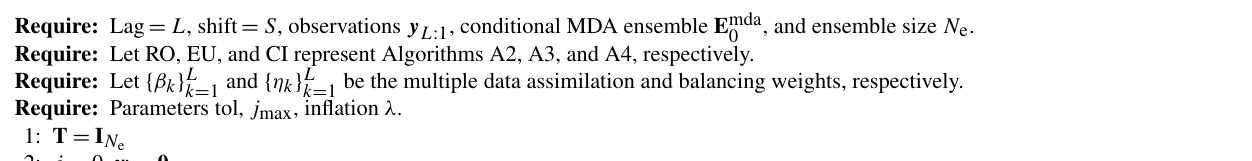
Algorithm A13 Gauss–Newton IEnKS in the MDA transform